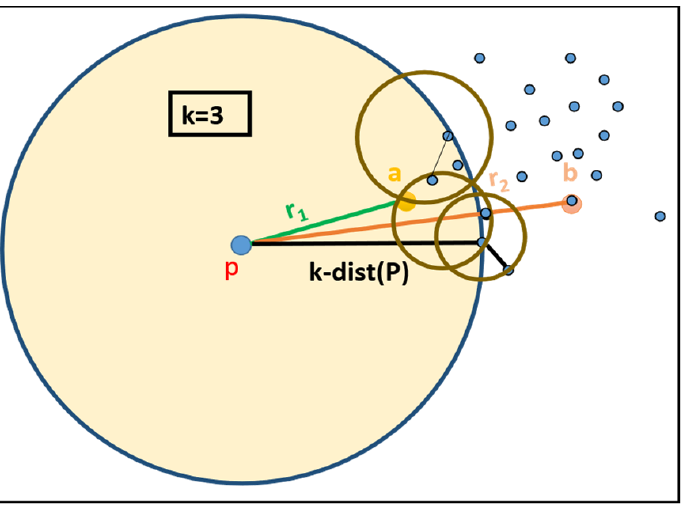
Figure 10. A conceptual diagram demonstrating reach ‐ dist k ( a , p ) for k = 3 and k ‐ dist ( p ), k ‐ distance neighborhood of p